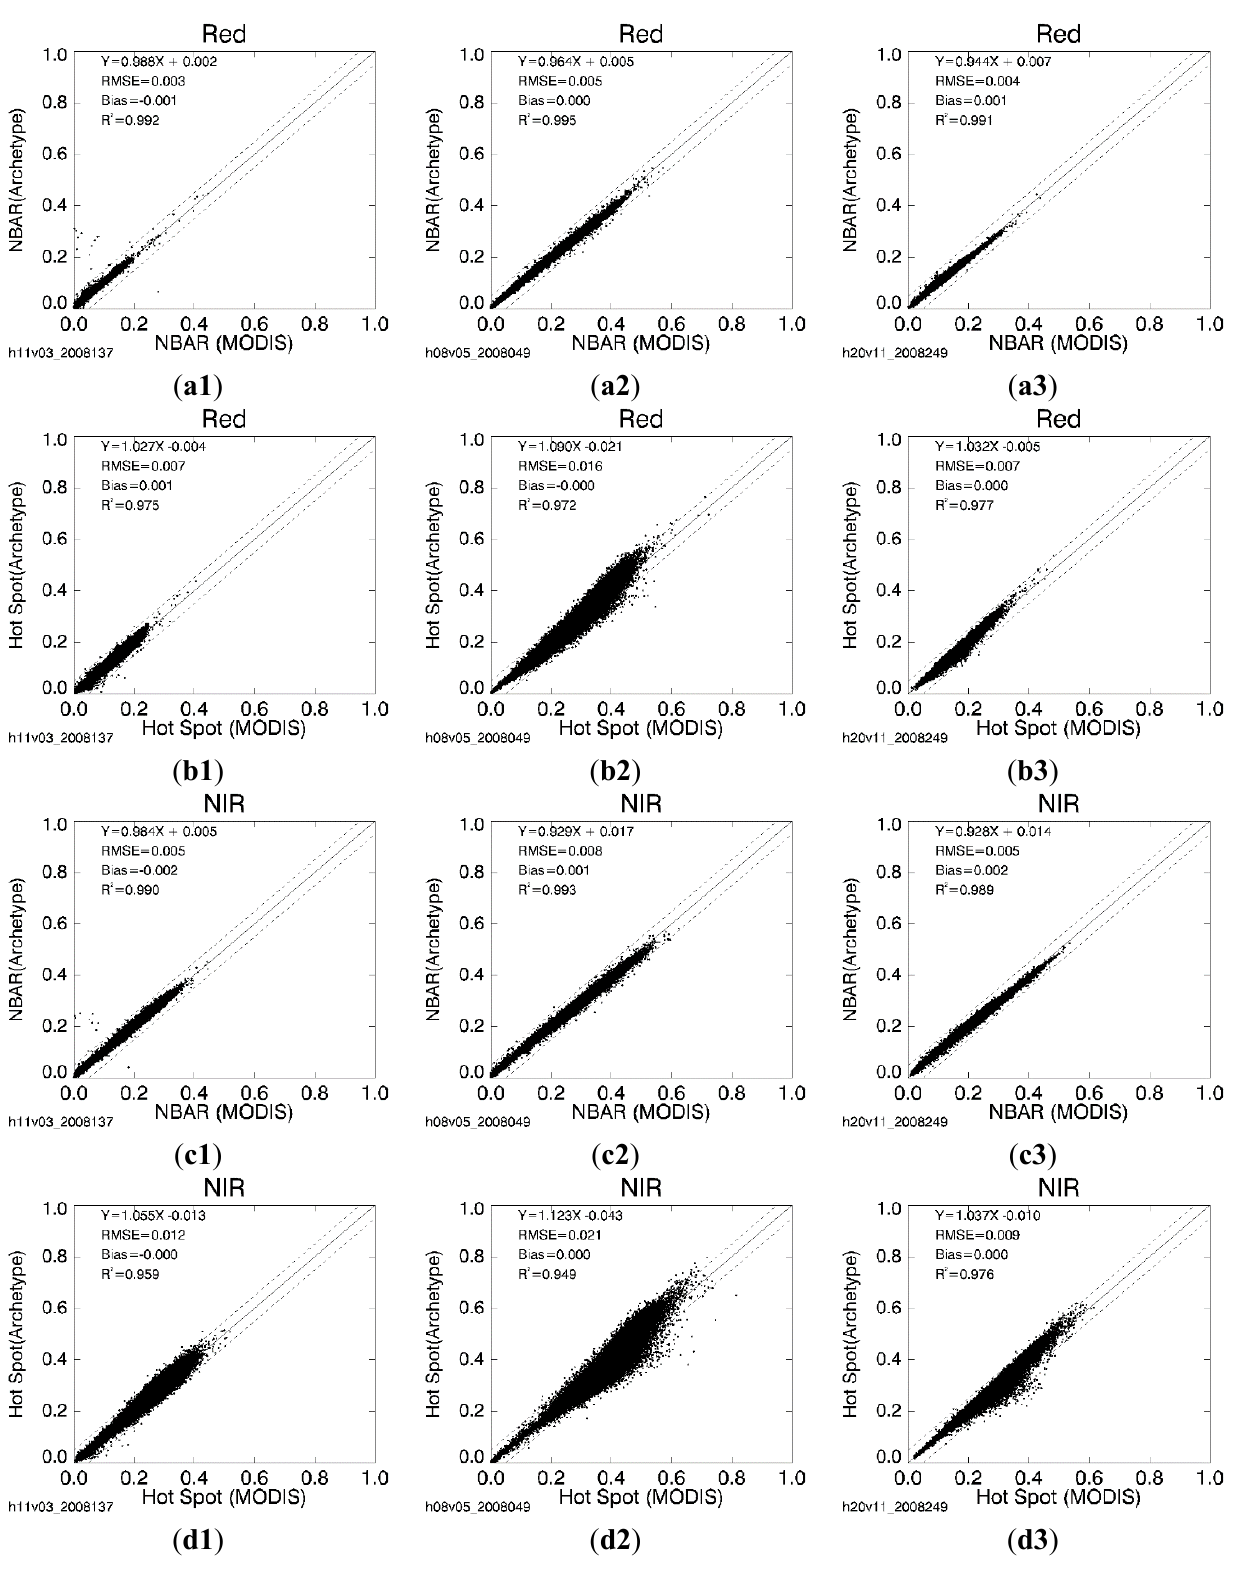
Figure 6. Comparisons of directional reflectance in the ( a , b ) red and ( c , d ) NIR bands in the (a, c) nadir-view and (b, d) hotspot directions. Reflectances are retrieved from the adjusted BRDF archetypes ( y -axis) and MODIS BRDFs ( x -axis) for tiles H11V03 (1st column, year 2008, day 137), H08V05 (2nd column, day 49) and H20V11 (3rd column, day